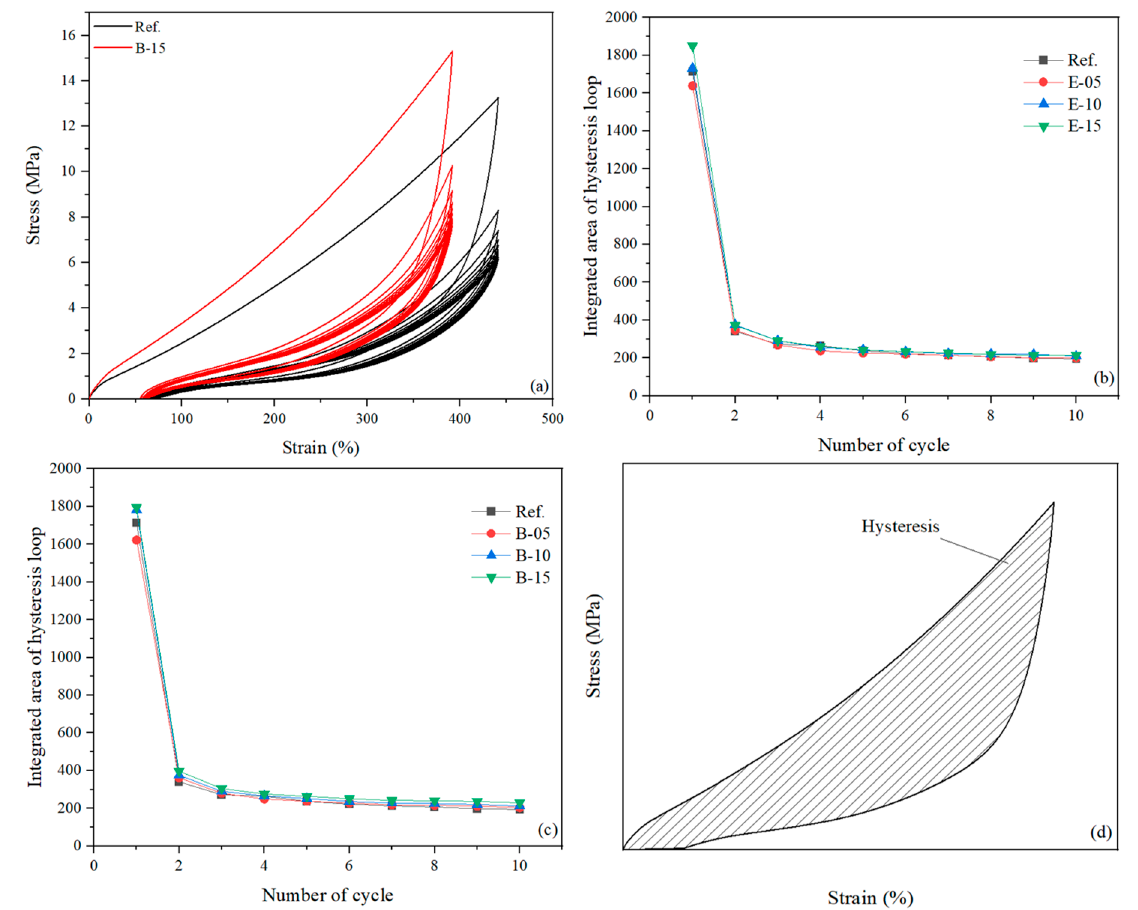
Figure 8. ( a ) Stress–strain curves of the reference sample (Ref.) and B-15 vulcanizate under a cyclic tensile deformation for 10 cycles. Integral area of hysteresis loop as a function of cycle number of the vulcanizates from ( b ) Set A, with extra addition of EMZ, and ( c ) Set B, with blending of EMZ. ( d ) Schematic illustration of how to calculate the values of hysteresis from the loading and unloading stress – strain curves .